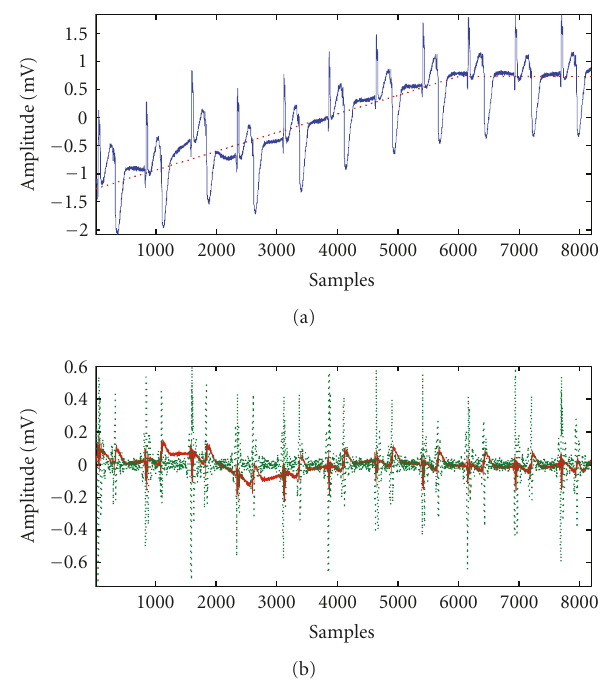
Figure 12: Simulated baseline perturbation removal and noise re- duction for an abnormal ECG. (a) MIT-BIH record 207, and the added baseline trace, (b) di ff erences between WT (dashed line) and MABWT (solid line) processed signals and the original